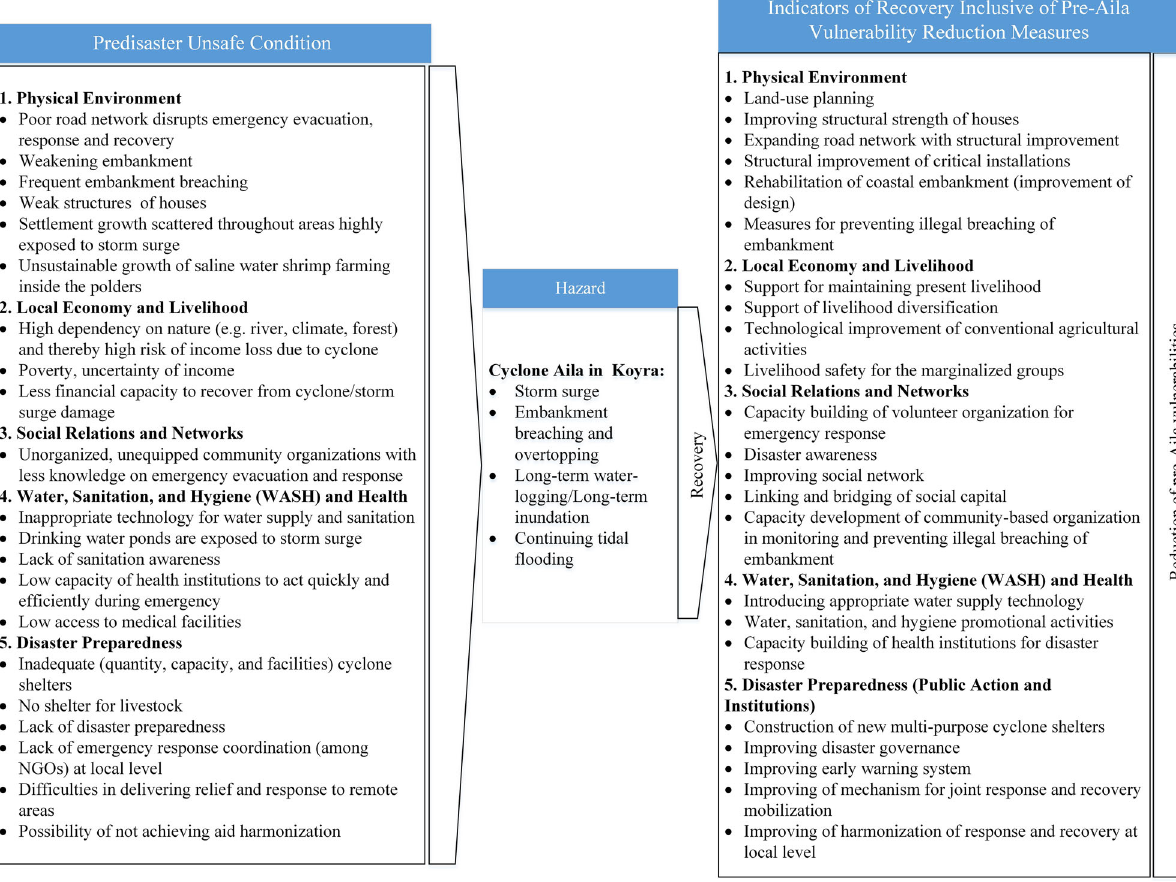
Fig. 4 Pre-Aila vulnerabilities and indicators of the recovery contributing to Pre-Aila Vulnerability Reduction (PAVR)